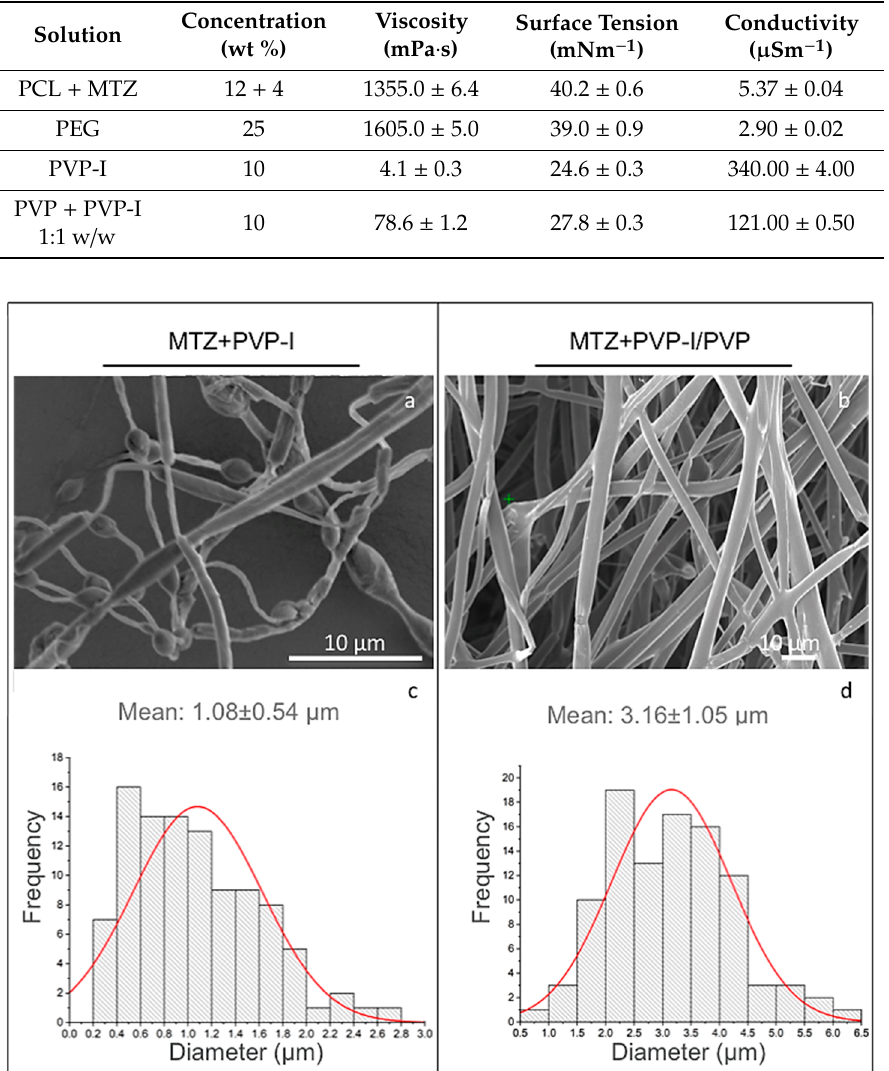
Figure 2. ( a , b ) SEM images of the fibers, and ( c , d ) the corresponding fiber diameter distribution profiles. Left panel: beaded trilayered fibers, generated with 10 wt % PVP-I in the middle layer. Right panel: smooth trilayered fibers, generated with 10 wt % PVP-I/PVP (1:1 w/w) in the middle layer. The bead-free, smooth continuous fibers comprising PCL + MTZ, PVP-I/PVP (1:1) and PEG,